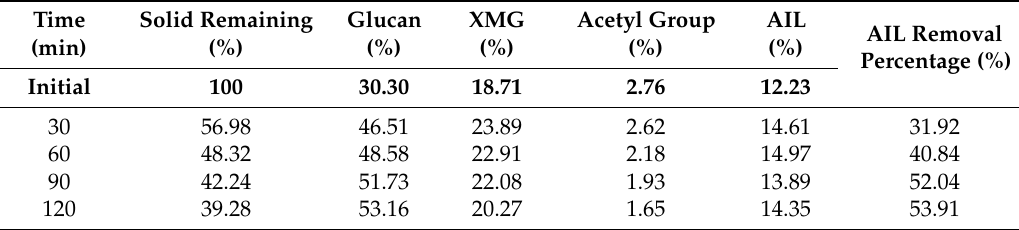
Table 3. Change in composition of corn stover after the combined ball mill and organosolv pretreatment performed at 170 ◦ C with 50 rpm rotation.